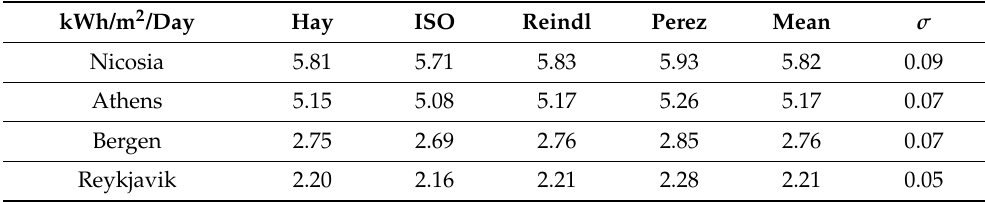
Table 2. Daily Energy outcome at the suggested optimum tilt angle for test cities as calculated with each model, the mean and standard deviation σ for each city as calculated from model’s prognosis.